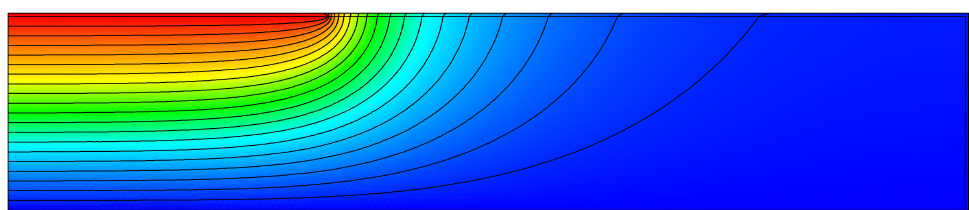
Figure 5. Contours of the electrical